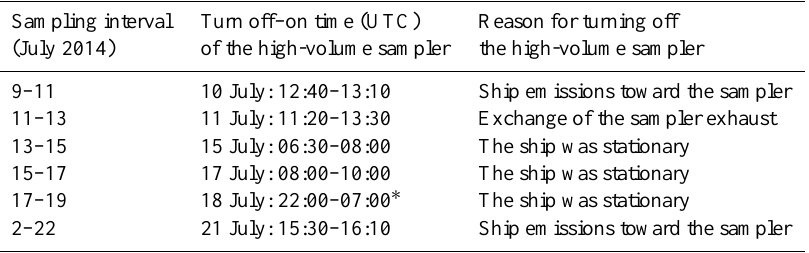
Table 1. Periods greater than 30min when the high-volume sampler was off to avoid contamination from ship emissions. The sampling interval was 2 days, starting from